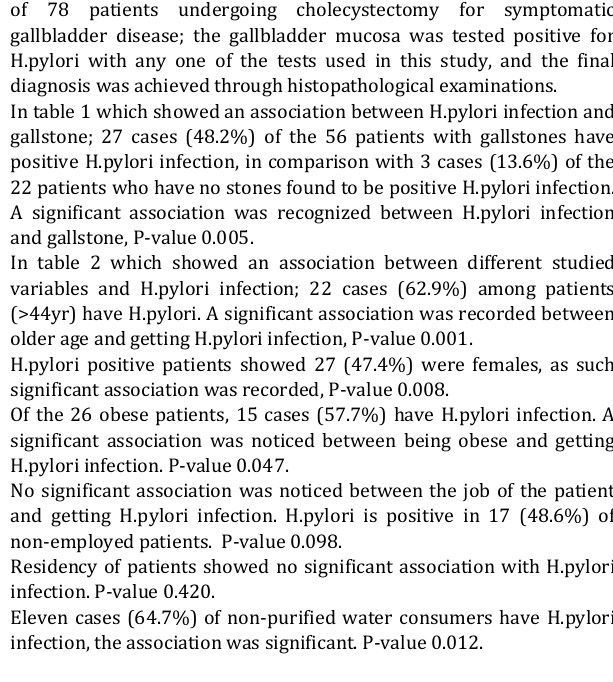
Association between different studied variables and H.Pylori infection.